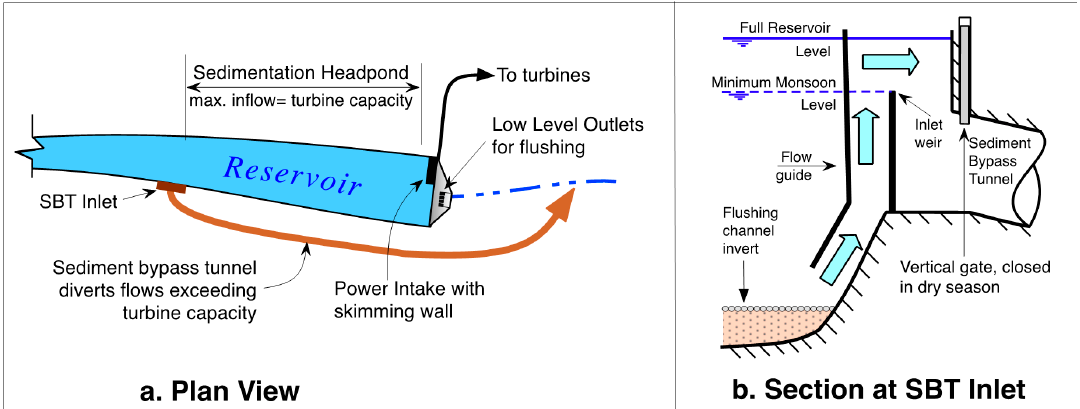
Figure 7. ( a ) At peaking run-of-river hydropower plants, use of type-C sediment bypass tunnel power peaking pool during the dry season. ( b ) Section through SBT inlet with flow guide and weir. Table 2. Operating Strategy for Bypass around Sedimentation